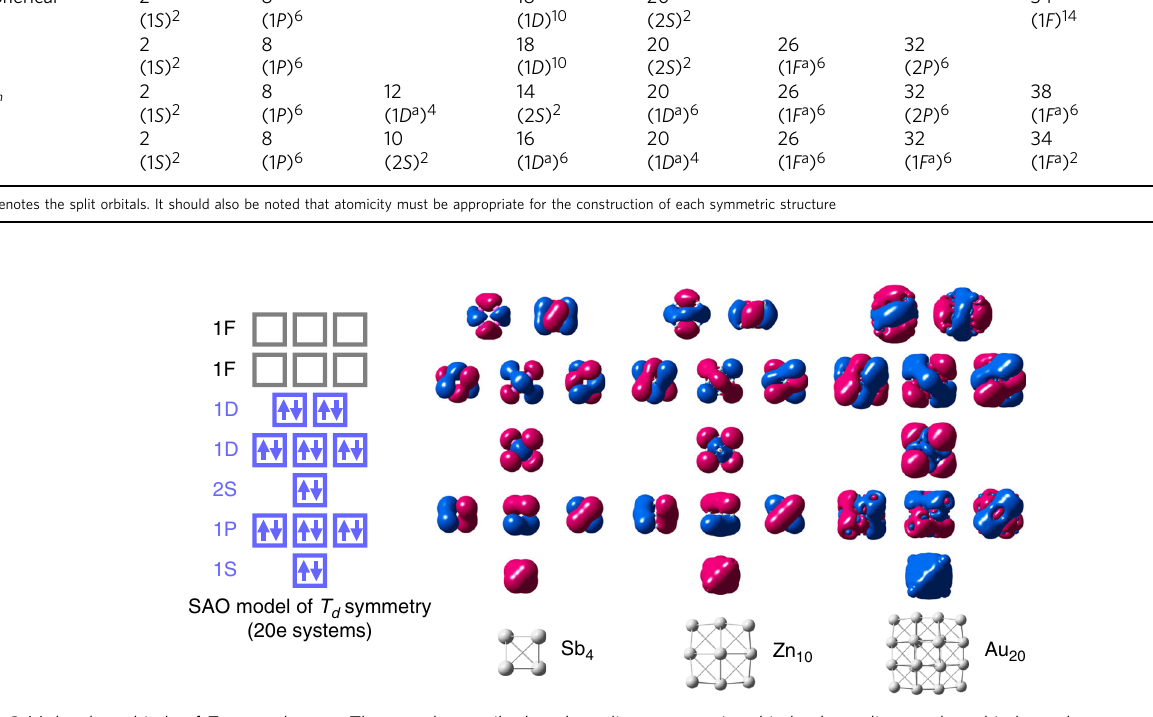
Table 2 Magic numbers of valence electrons based on the SAO models Magic number of valence electrons Spherical